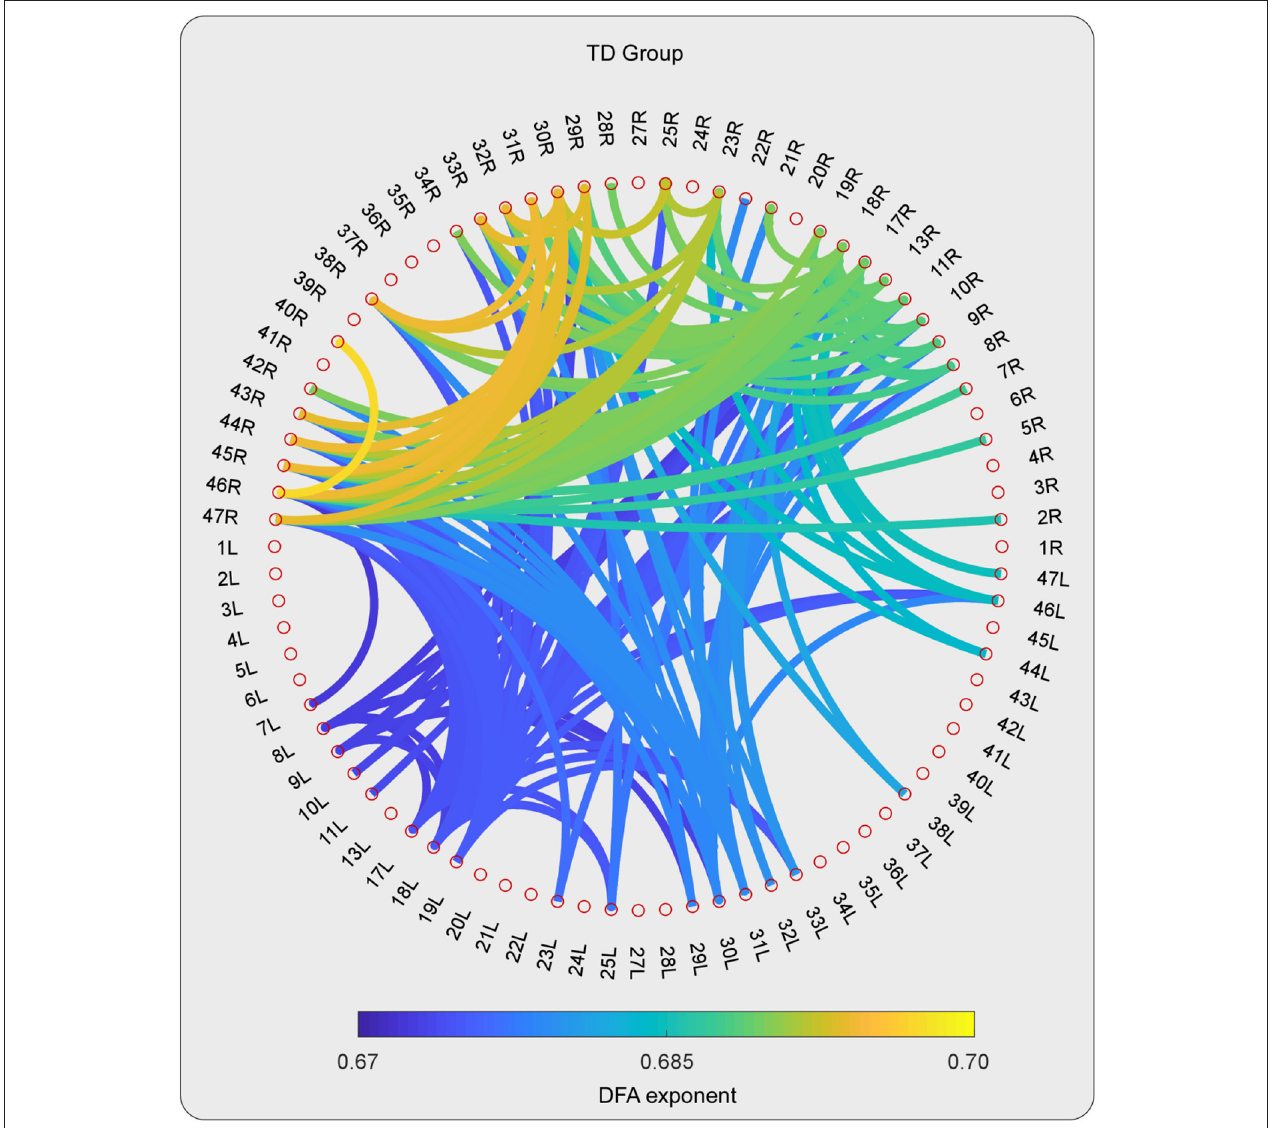
FIGURE 3 | The DFA exponents of TV-PS time series in high-gamma oscillations for TD group. The magnitude of DFA exponent is color coded. Note that, only the pairs with 10% largest DFA exponent are shown.